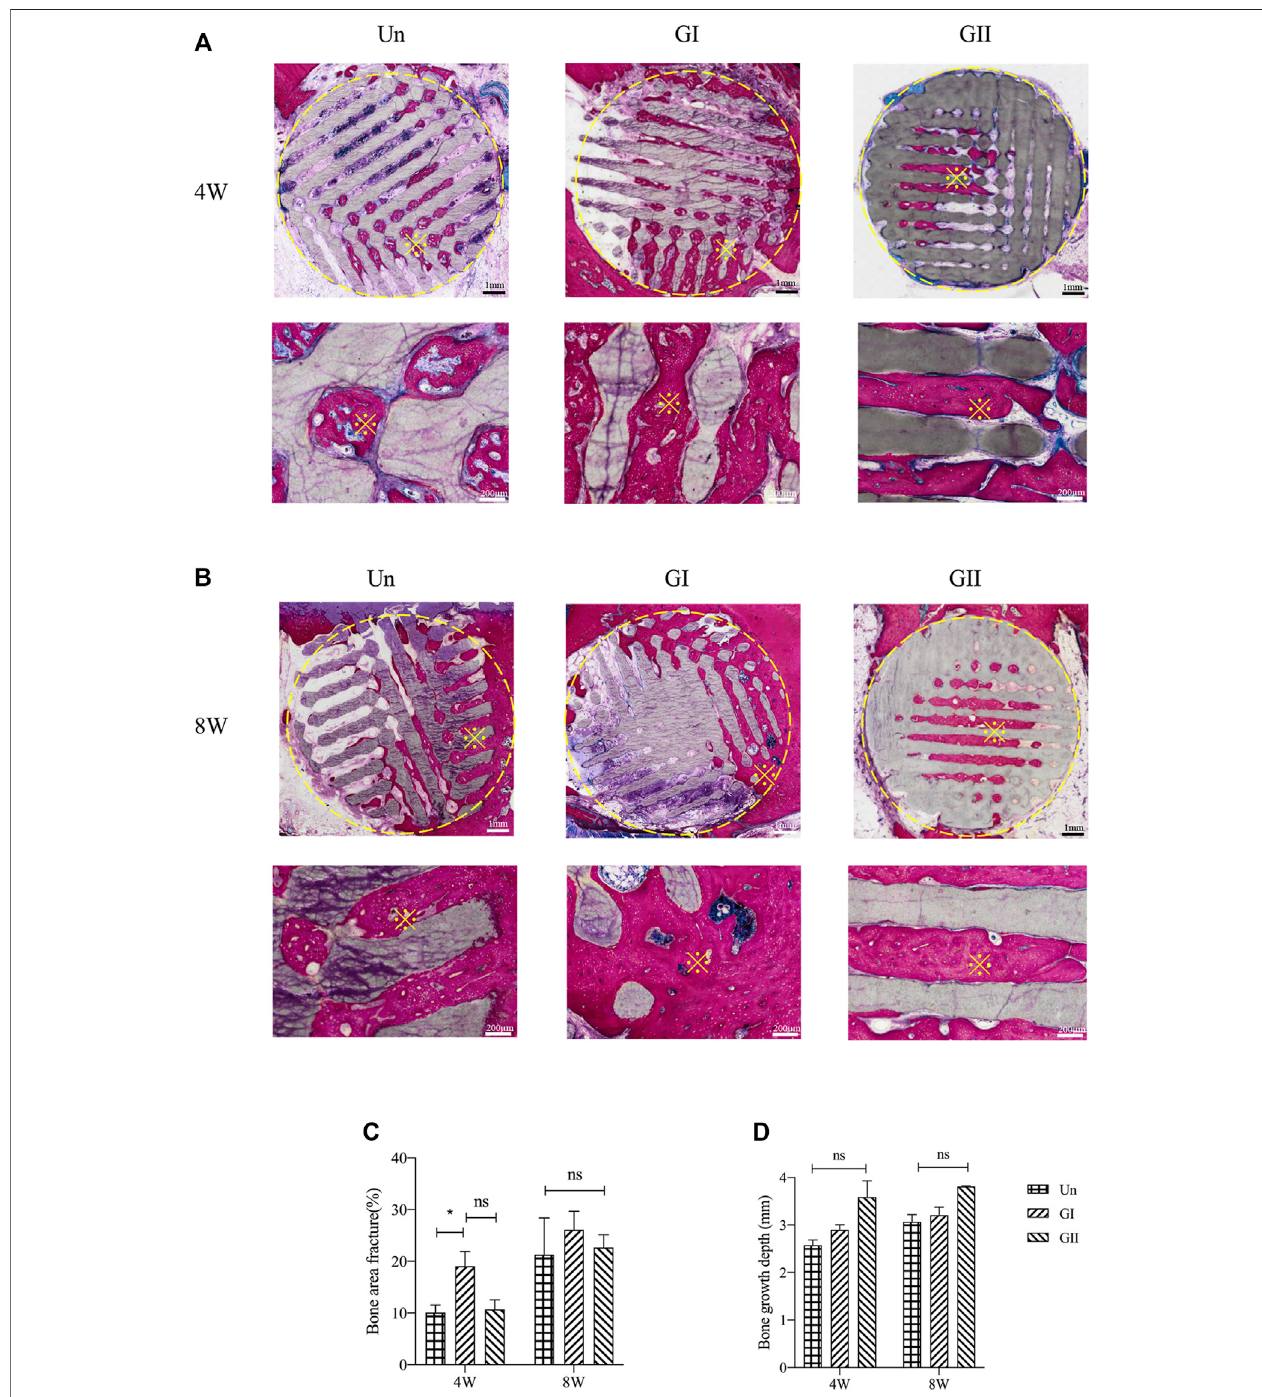
FIGURE 8 | Histological analysis of porous scaffolds implanted into rats after 4 weeks (A) and 8 weeks (B) , below is a partial enlargement of the fi gure above, ※ with yellow represents locally magni fi ed point. Bone area fraction (C) and bone growth depth from the outer of the scaffold into the center (D) .